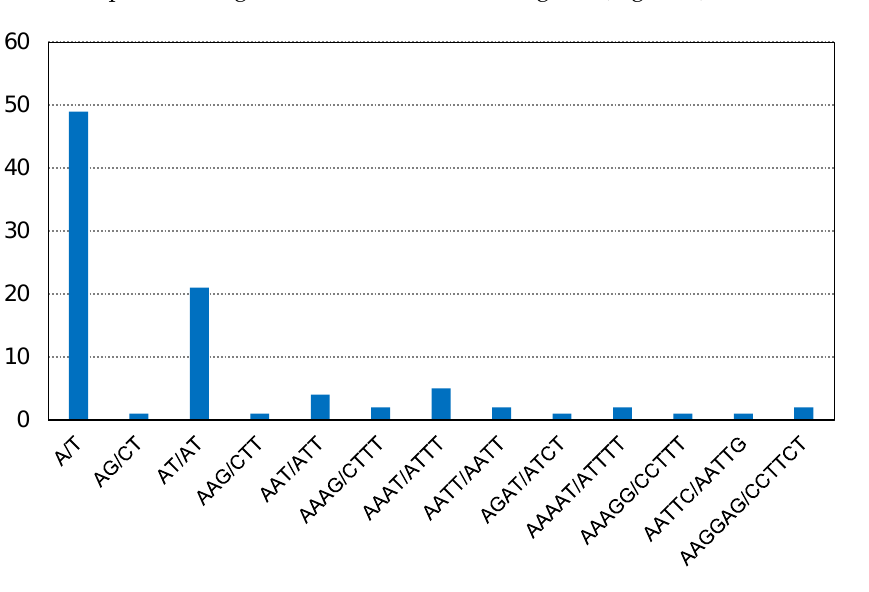
Figure 3. Number of different repeat units of SSRs.